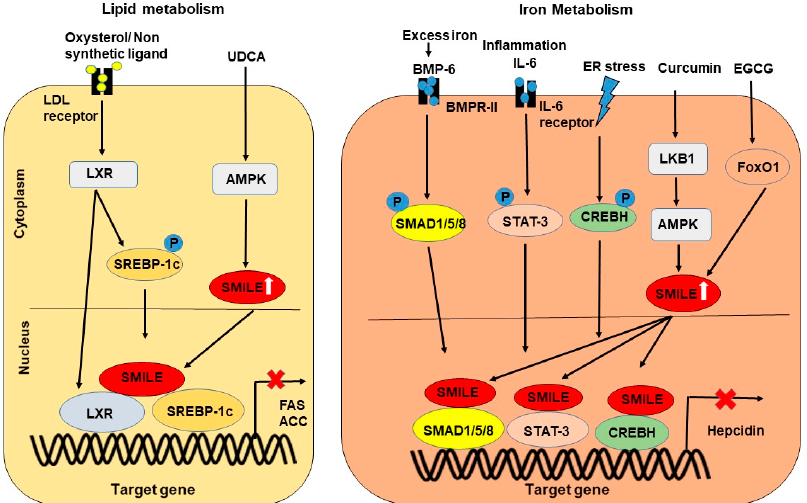
Figure 5. The role of SMILE in regulating lipid and iron metabolism ‐ During lipid metabolism, oxysterols binding activates the transcription factor SREBP ‐ 1C via LXR activation, and the action of UDCA induces SMILE via the AMPK pathway, which inhibits the transcription of ACC and FAS (left panel). Curcumin and EGCG induce the expression of SMILE. SMILE inhibits the action of SMAD1/5/8, which are activated due to excess iron levels via BMP ‐ 6 and STAT ‐ 3 (right panel). BMP ‐ 6 and STAT ‐ 3 are activated due to inflammation and ER stress induced by CREBH. Inhibition of the transcription factors by SMILE inhibits genes responsible for hepcidin production.